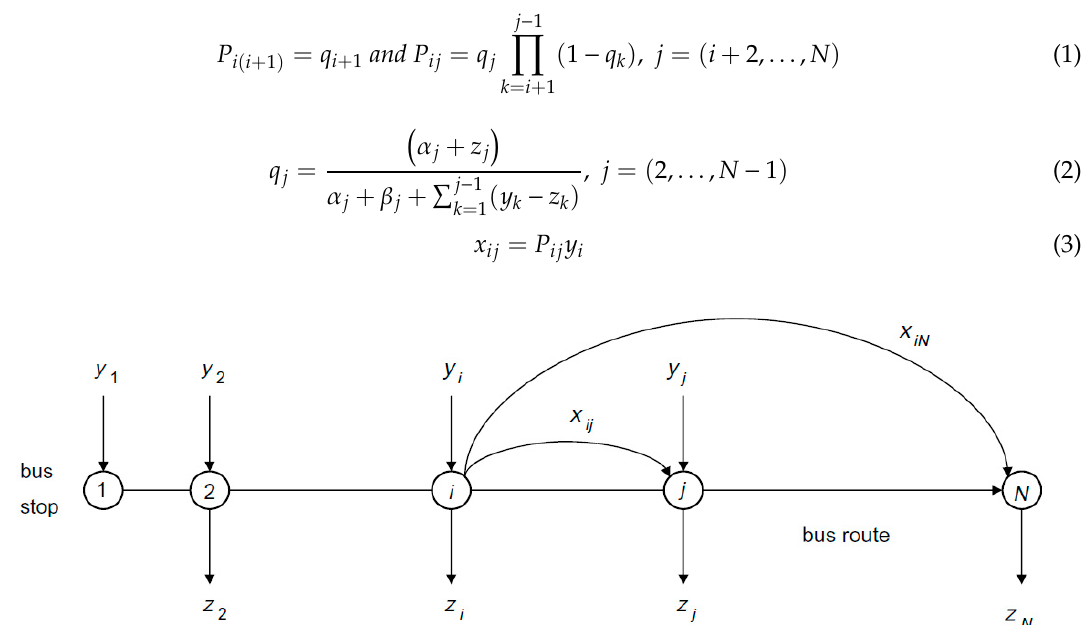
Figure 3. Flow of passengers along the route [22]